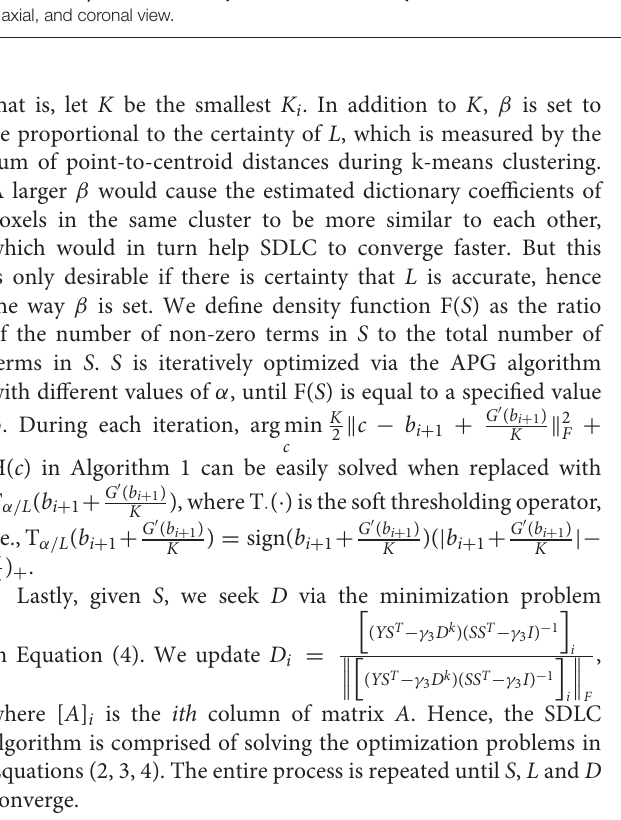
FIGURE 5 | Individual examples of the cerebellar parcellation into seven clusters. Each column shows the cerebellar parcellation of one subject in the sagittal, axial, and coronal